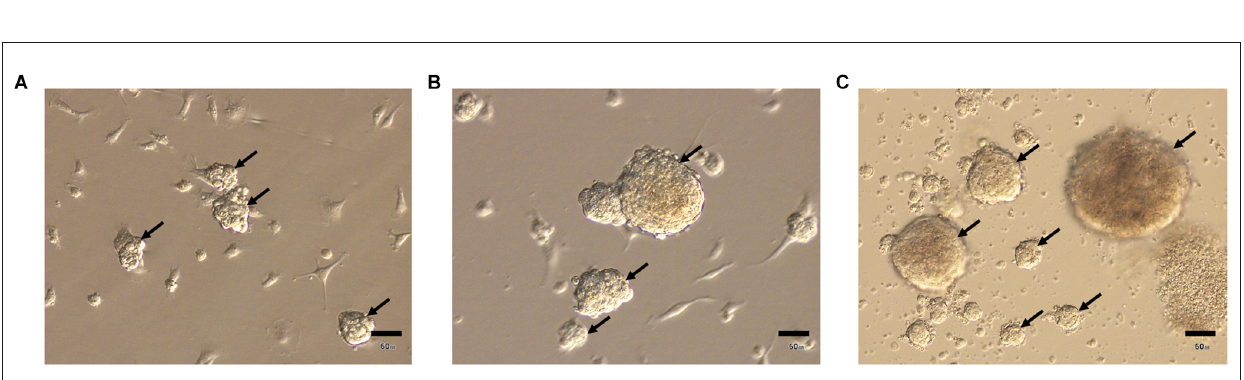
FIGURE2 Three-dimensional spheroids (arrows) formed by ADSCs, obtained from young (A) , old (B) , and ovariectomized old (C) animals. Light microscopy. Scale bar—50 µ m.